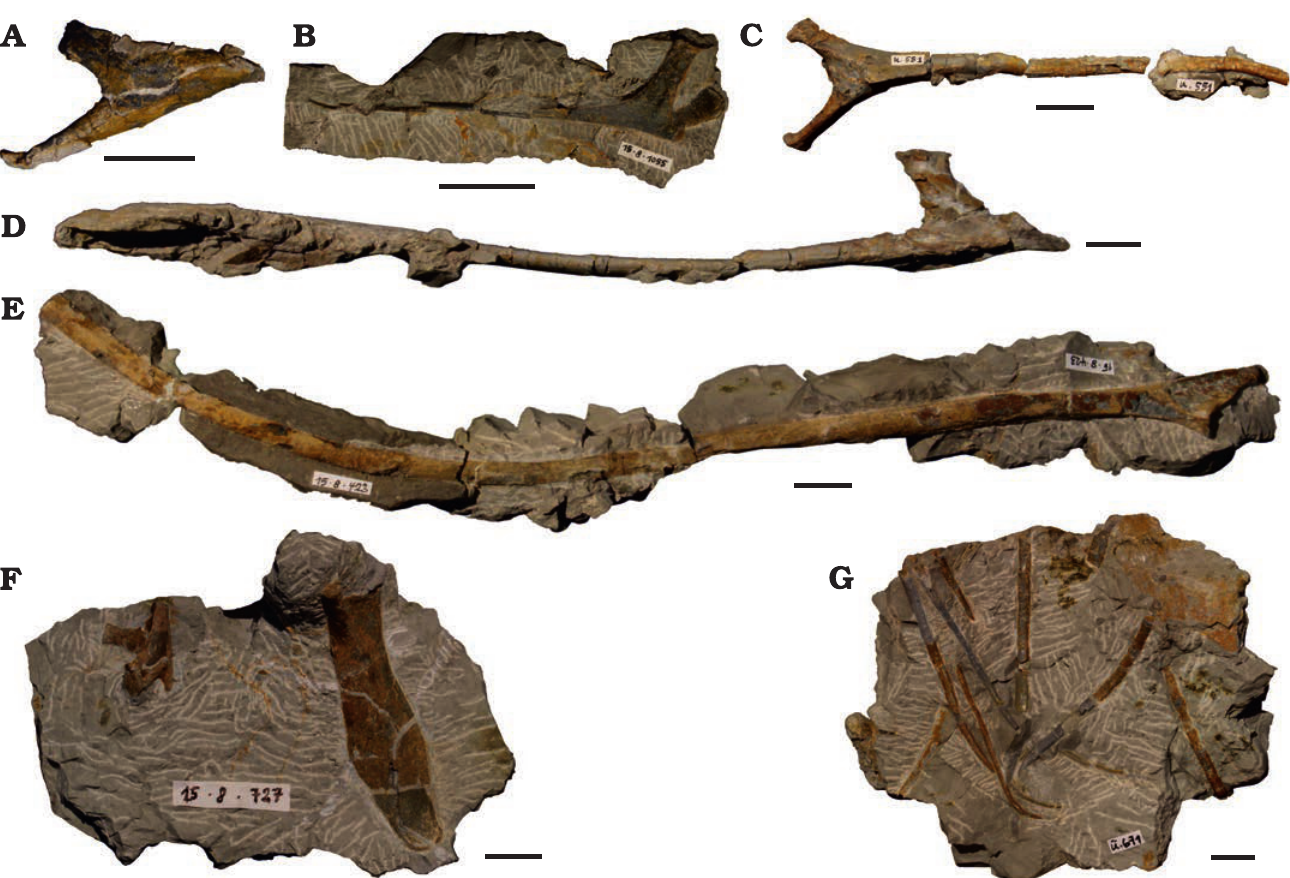
Fig. 6. Ribs of juvenile Plateosaurus cf. trossingensis Fraas, 1913 skeleton MSF 15.8B. from the Norian of Frick, Switzerland. A . Anterior cervical rib, MSF 15.8.2010, in lateral view. B . Middle cervical rib, MSF 15.8.1055, in lateral view. C . Posterior cervical rib, MSF 15.8.2011, in lateral view. D . Anterior dorsal rib, MSF 15.8.384, in anterior view. E . Posterior dorsal rib, MSF 15.8.423, in anteromedial view. F . Posterior dorsal rib and head of middle cervical rib, MSF 15.8.727, in medial view. G . Gastraliae, MSF 15.8.2012. Scale bars 10